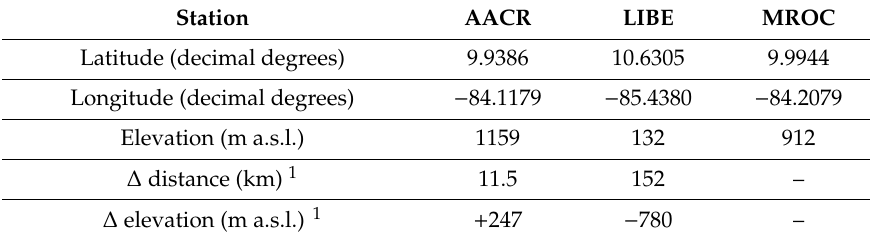
Table 1. The location details for AACR and LIBE GPS receivers in the Central Valley and northern Pacific region of Costa Rica and for the MROC radiosonde site used in this